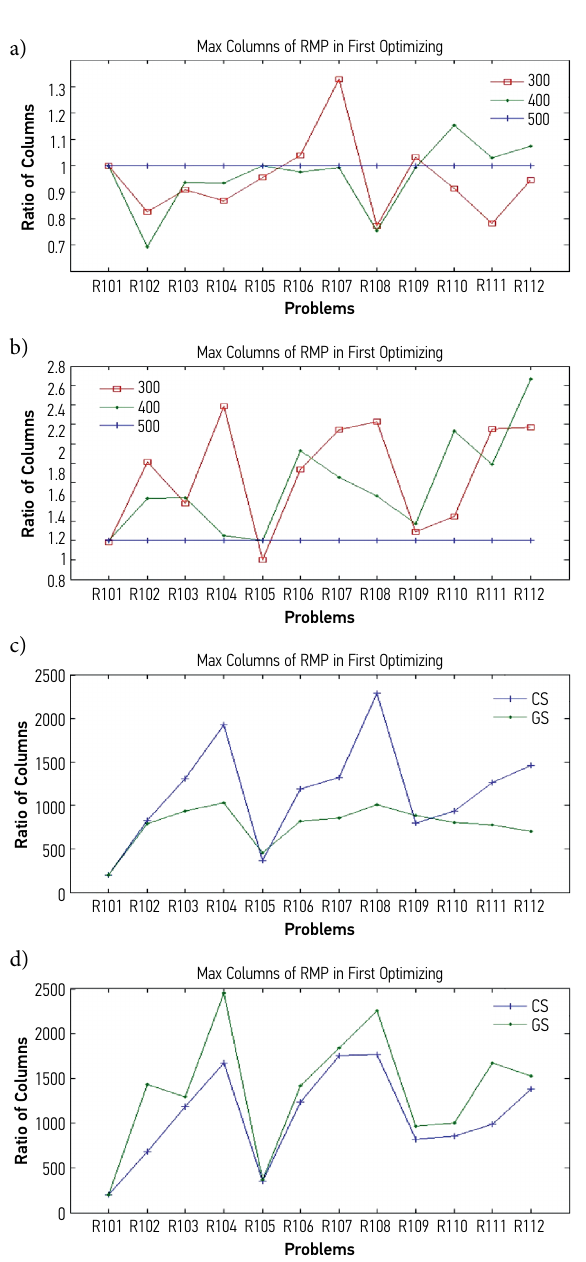
serial number of problems and the number of iterations without optimization, columns 3÷5 represent the mini- mum number of iteration and its heuristic function, col- umns 6÷8 represent the worst optimization, the column 9 represents the average number of iterations needed by